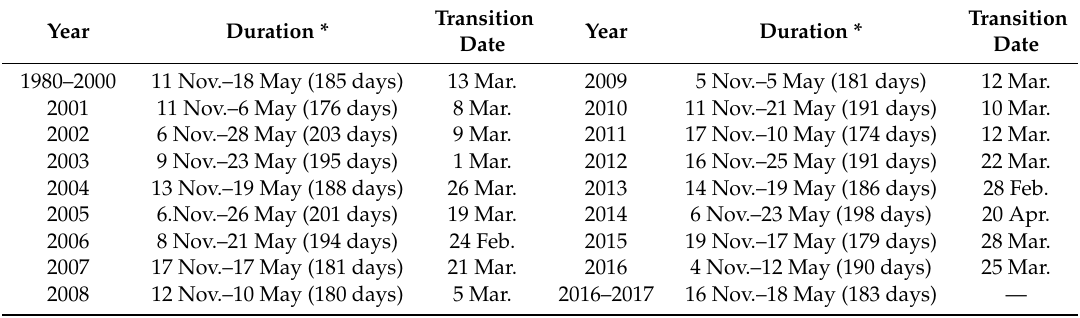
Table 1. Duration and transition date of Nam Co Lake ice cover from 1980 to 2016 based on MODIS land surface temperature (LST)